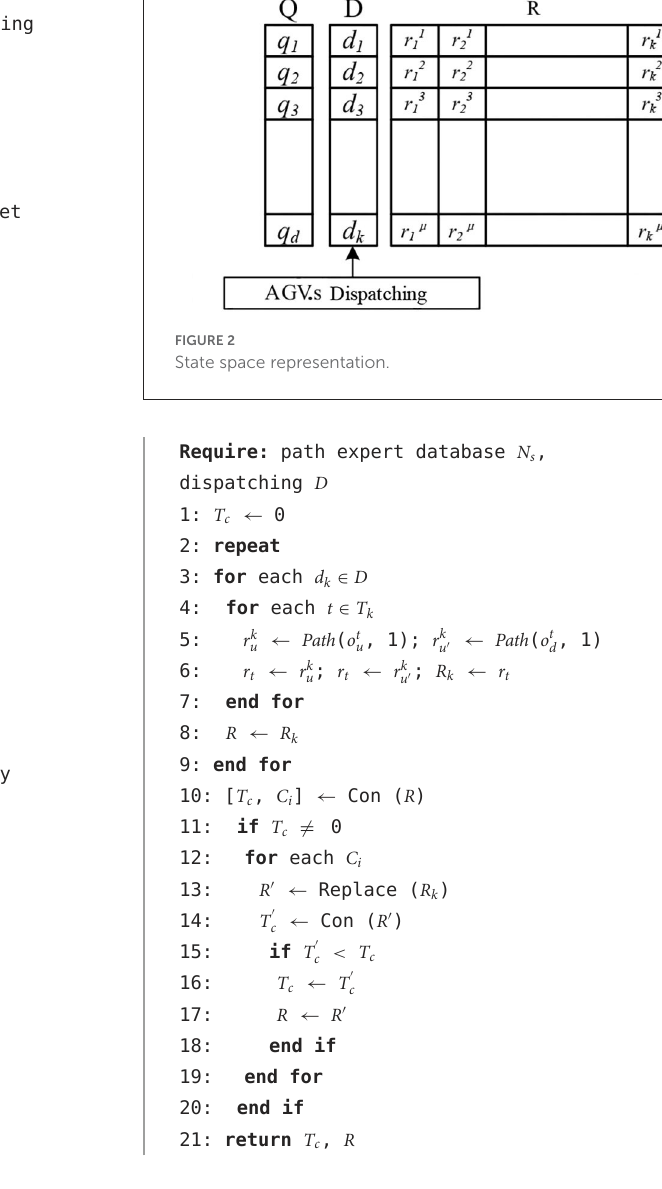
Algorithm 2. Select procedure for AGV